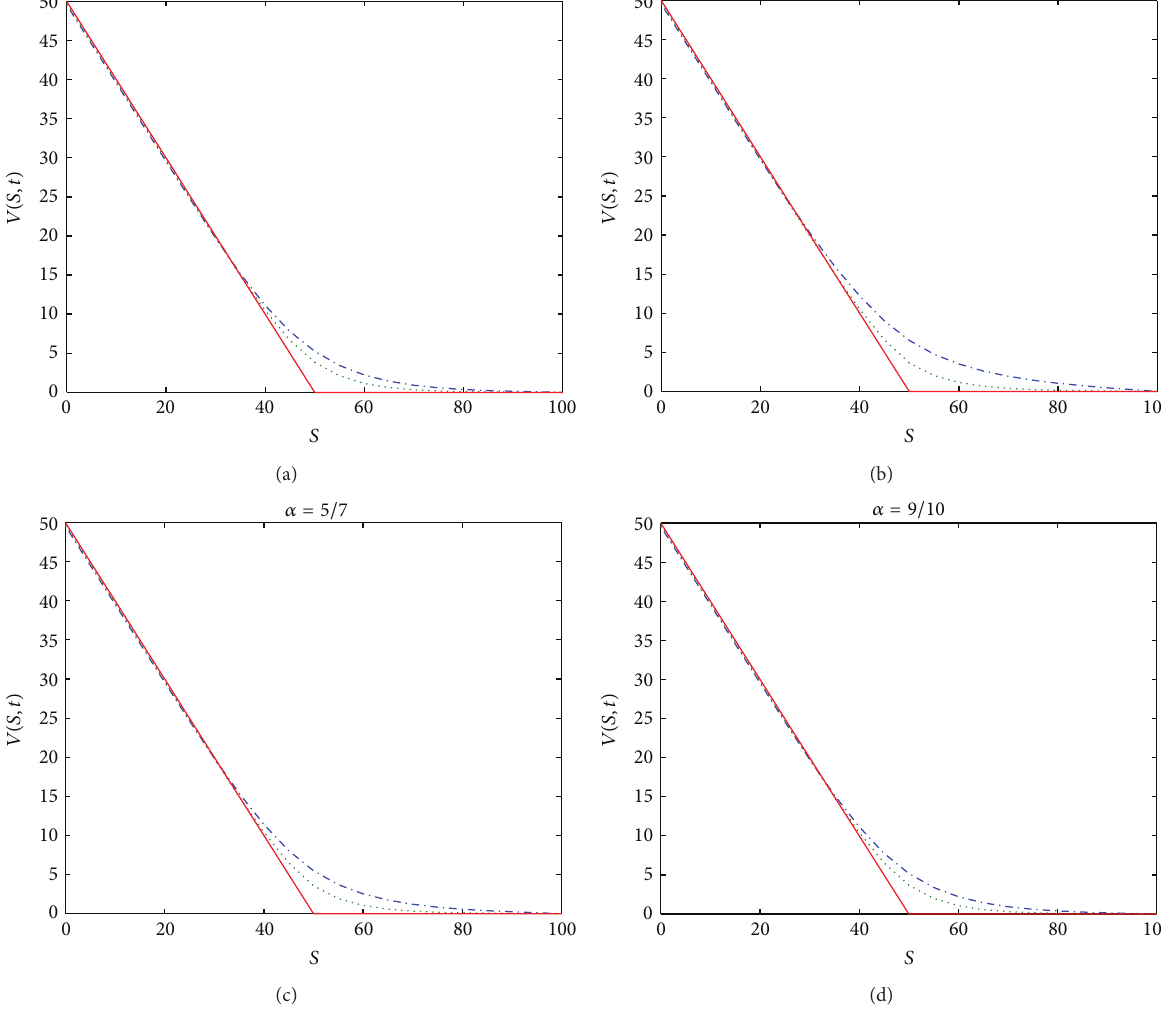
Figure 3: European put option. dash-dotted line: 𝑡 = 0.1 ; dotted line: 𝑡 = 0.5 ; solid line: 𝑡 = 1